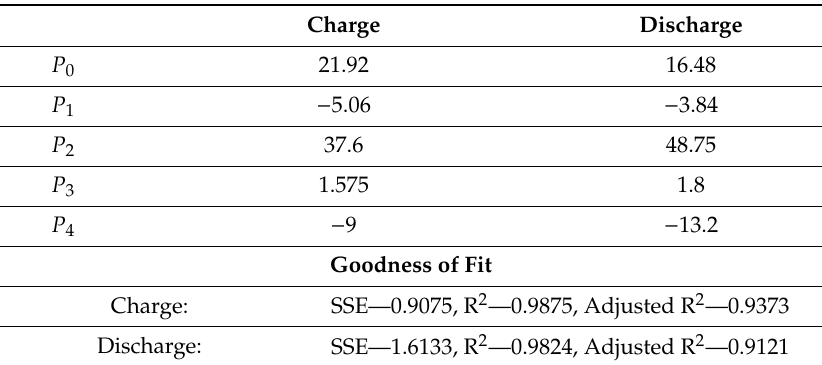
Table 8. Model Equation Coe ffi